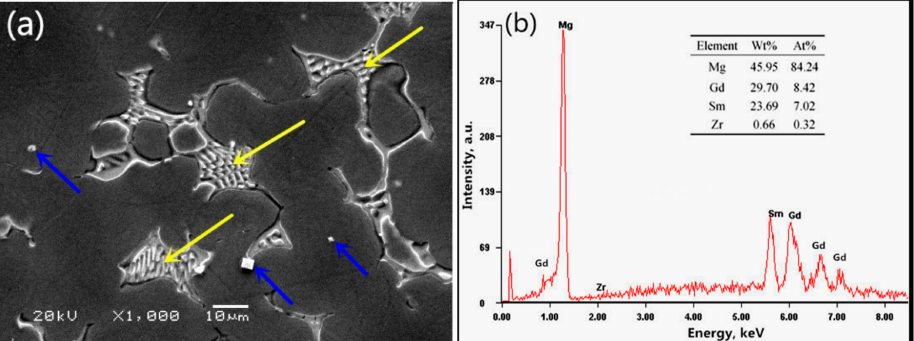
Figure 1. The SEM ( a ) and EDS ( b ) results for the Mg–8.08Gd–2.41Sm–0.30Zr as-cast alloy.